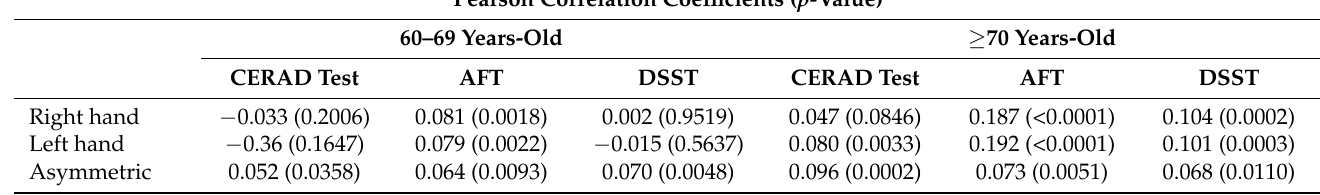
Table 2. Pearson correlation coefficients between HGS and cognitive function tests according to age